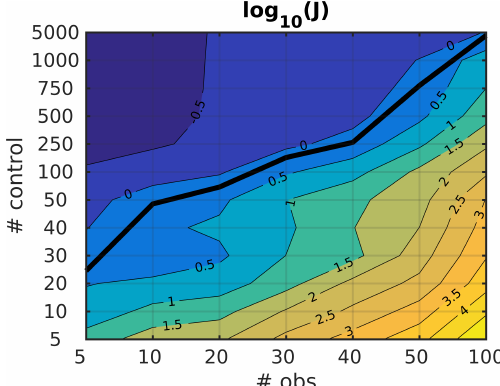
Figure 6. Influence of the number of observations and controls on the ability to track the chaotic pendulum. The base-10 logarithm of the cost function, log 10 (J) , is calculated as a function of the num- ber of evenly spaced observations over a 50s window (the abscissa), and the number of effective degrees of freedom in the control per- turbations to the forcing (ordinate). A χ 2 statistical test determines the limit where 95% of realizations are expected to have smaller J values (thick, black line); therefore, cases below this threshold represent an unacceptable fit to the data at the 5% insignificance